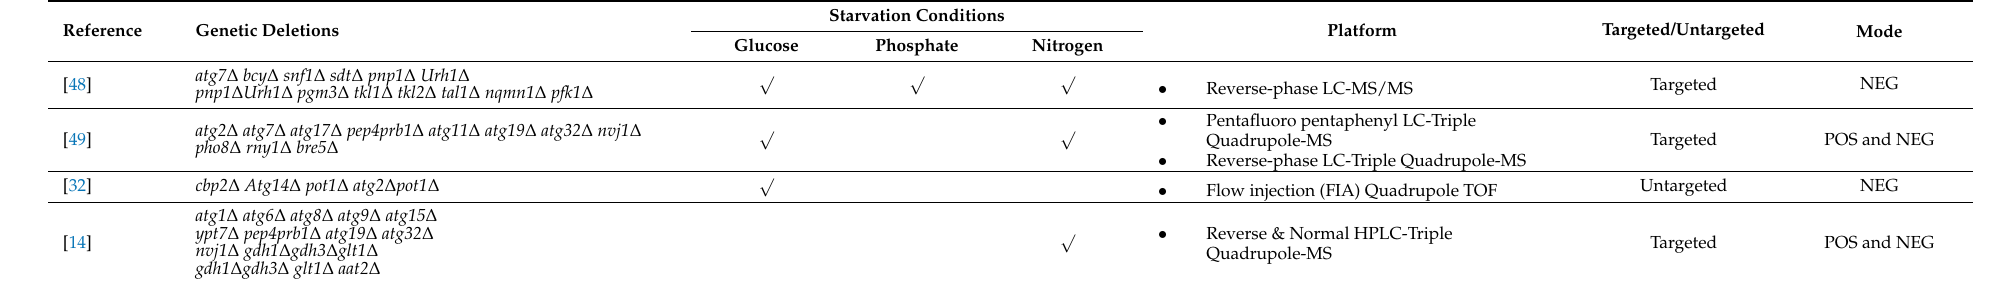
Table 1. The summary of data extracted from eligible articles. Abbreviations: POS (Positive Mode), NEG (Negative Mode), HPLC (High-performance liquid chromatography), MS (Mass Spectrometry).